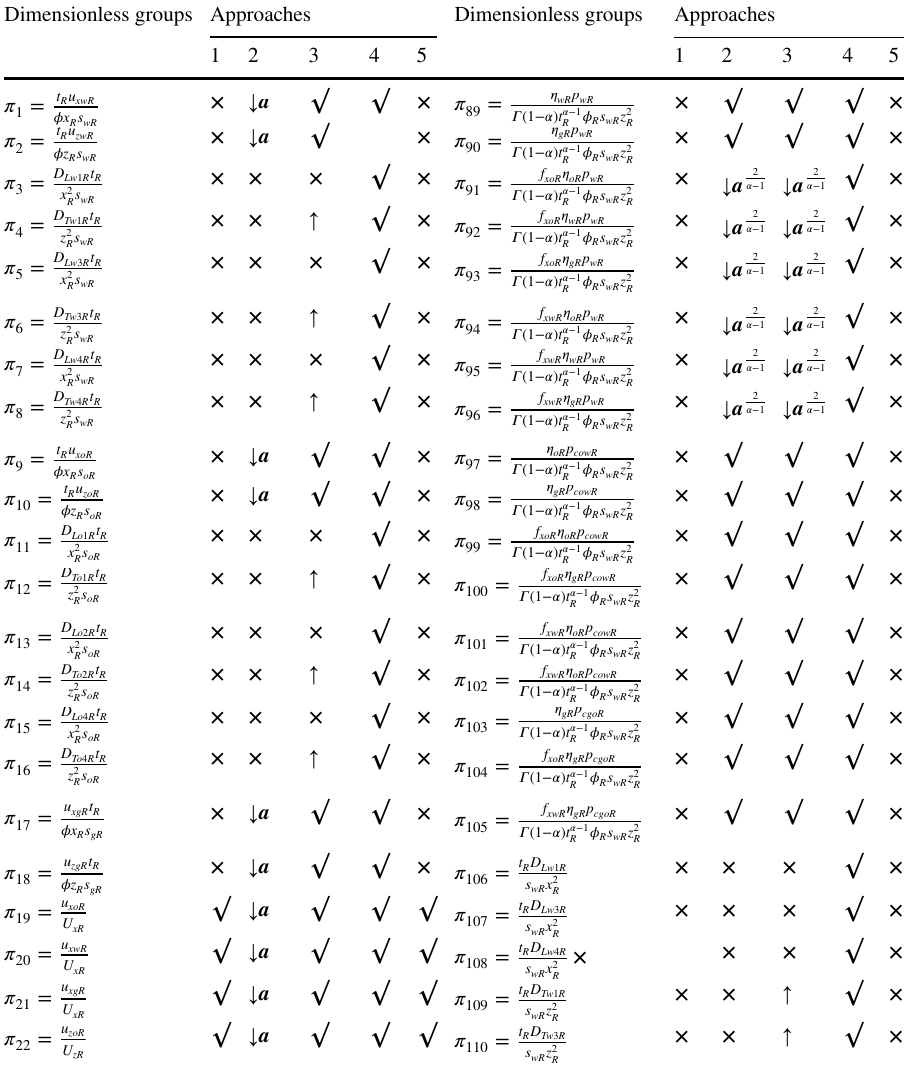
Table 3 Influence of different Dimensionless groups Approaches Dimensionless groups dimensionless groups on each approach